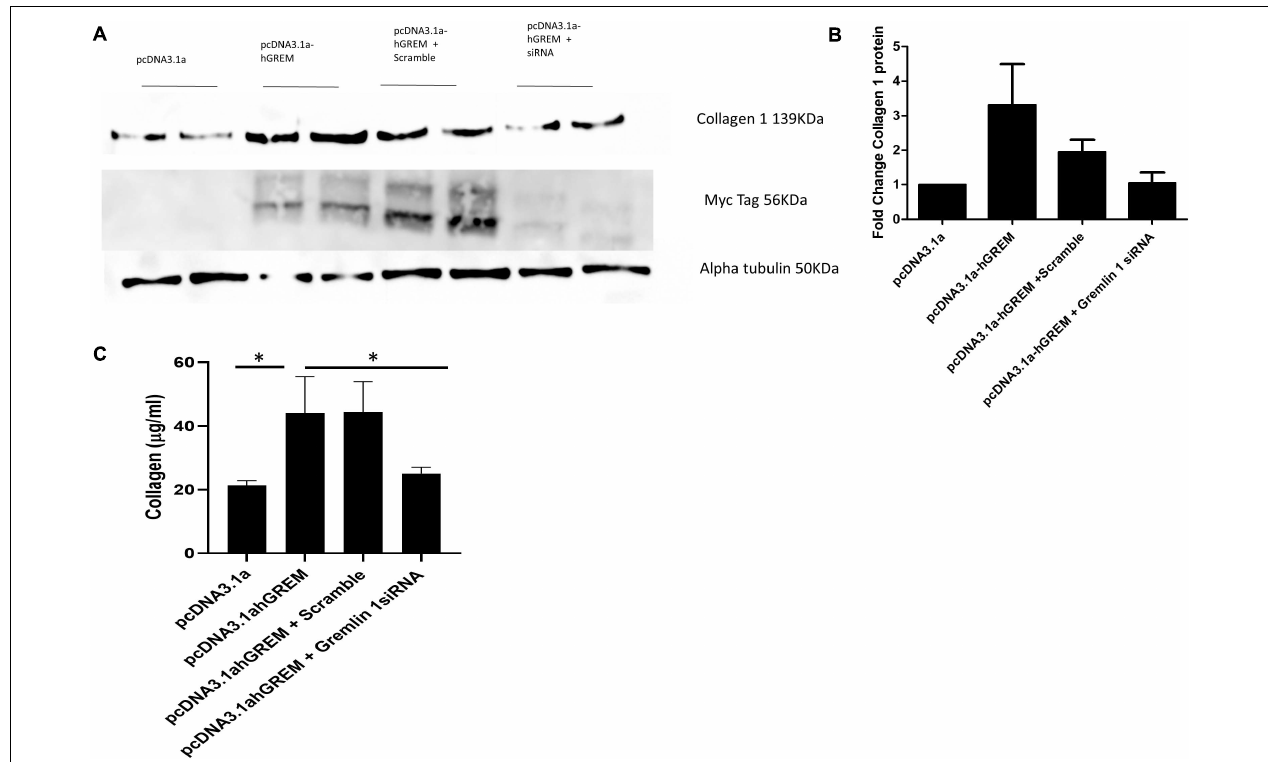
FIGURE 4 | siRNA to Gremlin-1 reduces collagen expression. Treatment of NHDF wit Gremlin-1 siRNA: NHDF were co transfected with the plasmid construct pcDNA3.1a and pcDNA3.1a-hGREM and either a non-targeting (scramble) or Gremlin-1 targeting siRNA. (A) Representative western blot and (B) densitometric analysis ( n = 4, t -test P -value vs. pcDNA3.1a—pcDNA3.1a-hGREM = 0.060653 ( SD ± 2.85), pcDNA3.1-hGREM + scramble = 0.044446 ∗ ( SD ± 0.82), pcDNA3.1a-hGREM + Gremlin-1 siRNA ( SD ± 0.63) = 0.723193 and P -value of pcDNA3.1a-hGREM + scramble vs. pcDNA3.1a-hGREM + Gremlin-1 siRNA = 0.0889. (C) Collagen was quantified by Sircol assay after transfection of pcDNA3.1, pCDNA3.1a-hGREM, pcDNA3.1a-hGREM and scramble siRNA or pcDNA3.1a-hGREM and siRNA Gremlin-1.